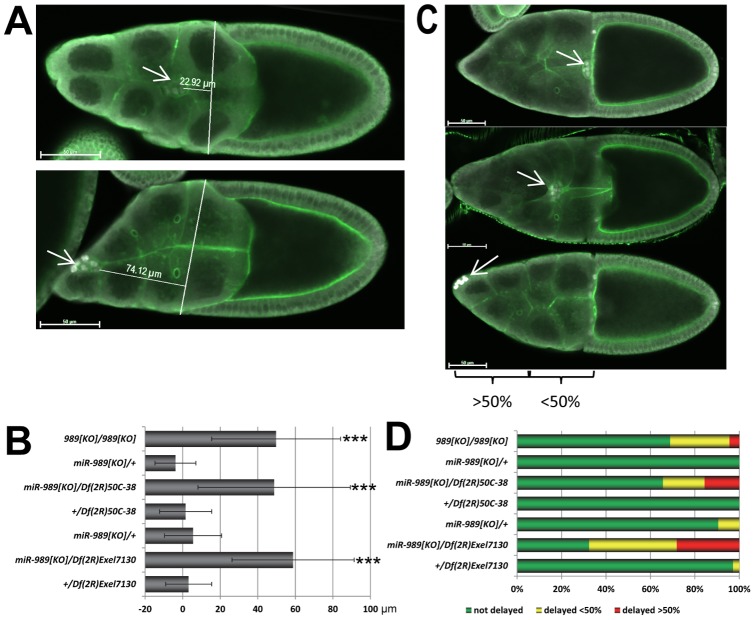
Border cell migration is delayed in miR-989 mutant egg chambers.A Late stage 9 egg chambers, labelled with α-Slbo (white) and Phalloidin (green). Border cell clusters are highlighted by arrows. In miR-989 mutant egg chambers, border cells were frequently delayed relative to the migrating main body follicular epithelium. B Quantification of the border cell migration phenotype in stage 9 and stage 10A egg chambers. Border cell migration is delayed in miR-989 mutant egg chambers compared to heterozygous control egg chambers (*** p<0.001). X-Axis labels are in μm, error bars denote standard deviation. C Stage 10B egg chambers, labelled with α-Slbo (white) and Phalloidin (green). Border cell clusters are highlighted by arrows. Frequently, border cells had not reached the oocyte by this stage in miR-989 mutant egg chambers. D Quantification of the border cell migration phenotype in stage 10B egg chambers.